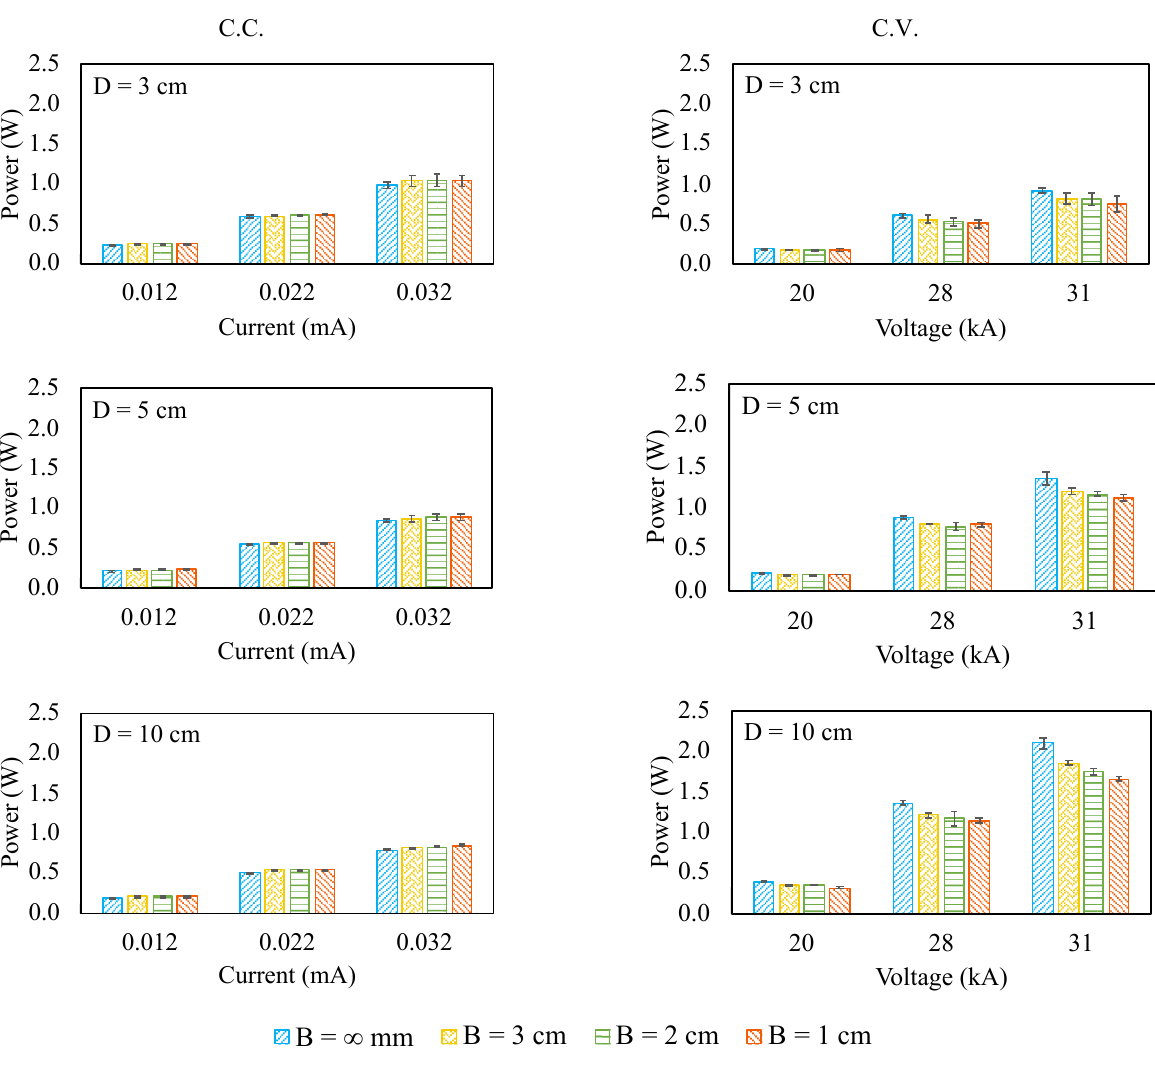
Figure 4. The corona power for the ionic wind pump under test.